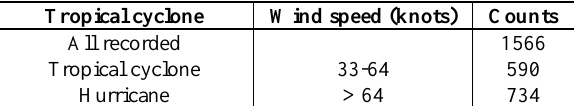
Table 3. Number of Atlantic hurricanes and TCs in HURDAT2.